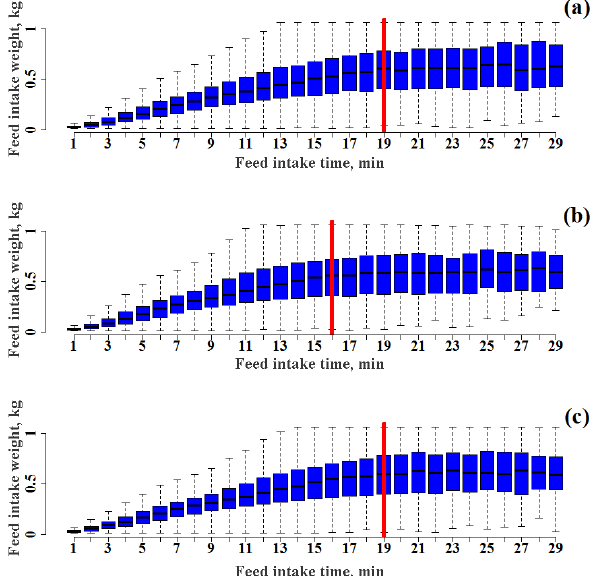
Figure 3. Effective feed intake times shown by red lines for (a) Duroc, 19min, (b) Landrace, 16min and (c) Yorkshire, 19min.